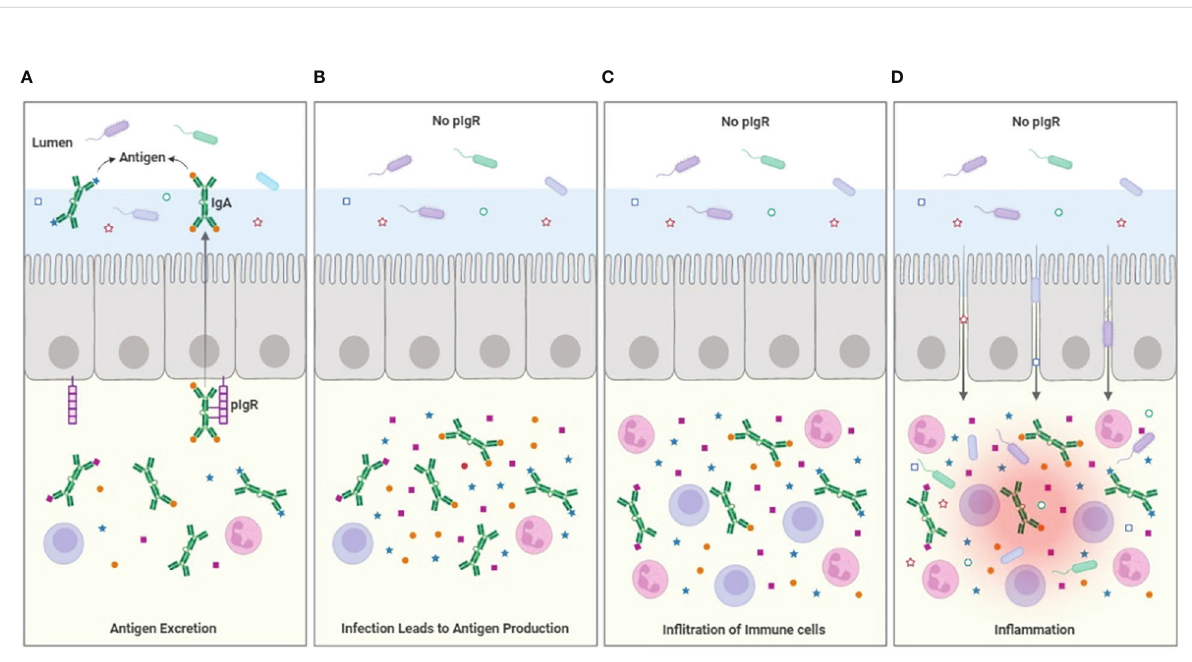
FIGURE 1 Model for antigen excretion. (A) The pIgR serves to excrete antigen bound to dimeric IgA, reducing the sub-epithelial antigen burden. Antigen excretion can occur through polyspeci fi c antibody from B-1 B-cells, but the ef fi ciency of the excretion process is improved by the induction of speci fi c IgA that occurs during e.g. infection. (B) In the absence of pIgR (or the secretable antibodies dIgA and pIgM), antigen accumulates in the sub-epithelial tissues. (C) The accumulation of infection- and microbiome-related PAMPs and antigen drives the in fi ltration of immune cells, increasing in fl ammation. (D) The cytokines produced by the in fl ammatory cells weakens the integrity of the epithelial barrier allowing ingress of bacteria from the lumen into the tissues, increasing in fl ammation further. The loss of epithelial patency also results in leakage of serum proteins including albumin into the